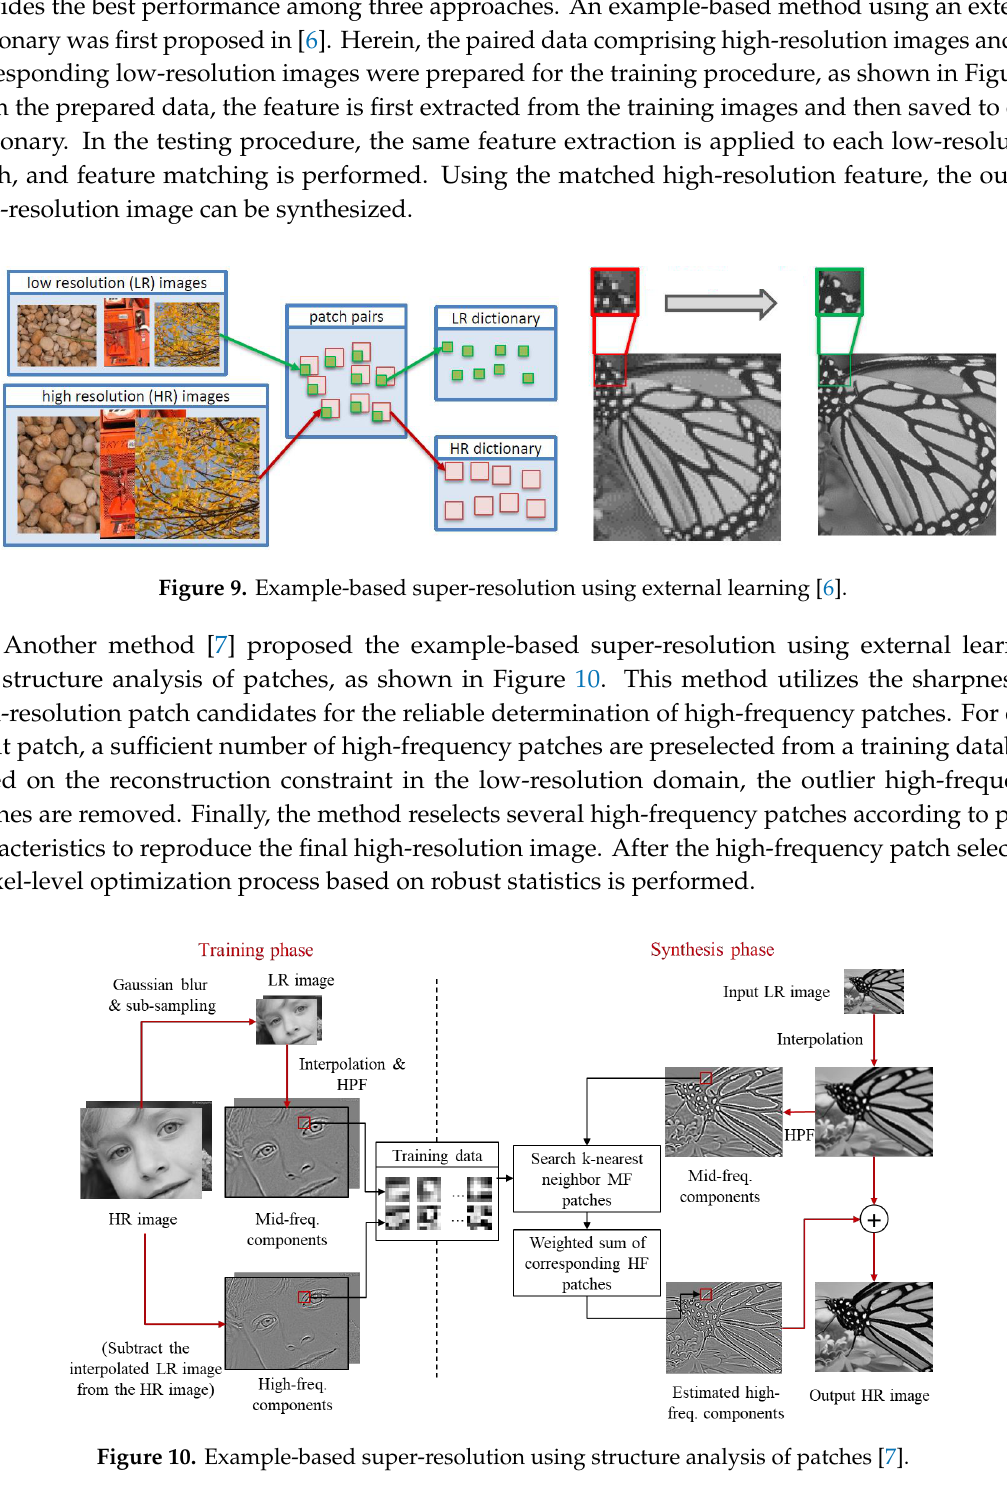
Figure 8. Classification of the approach to image super-resolution.